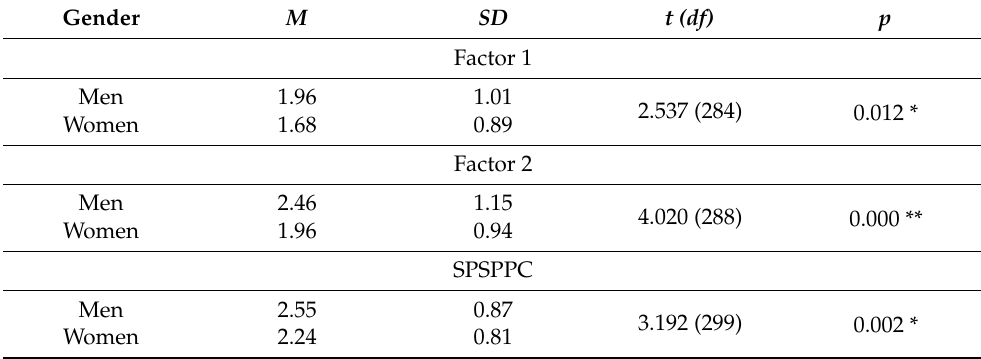
Table 3. Sexual prejudice levels by gender.